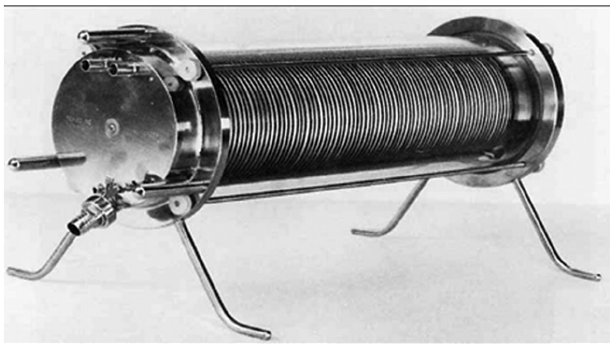
Fig. 3 - Disc oxygenator, 1956. Source: Souza & Elias,